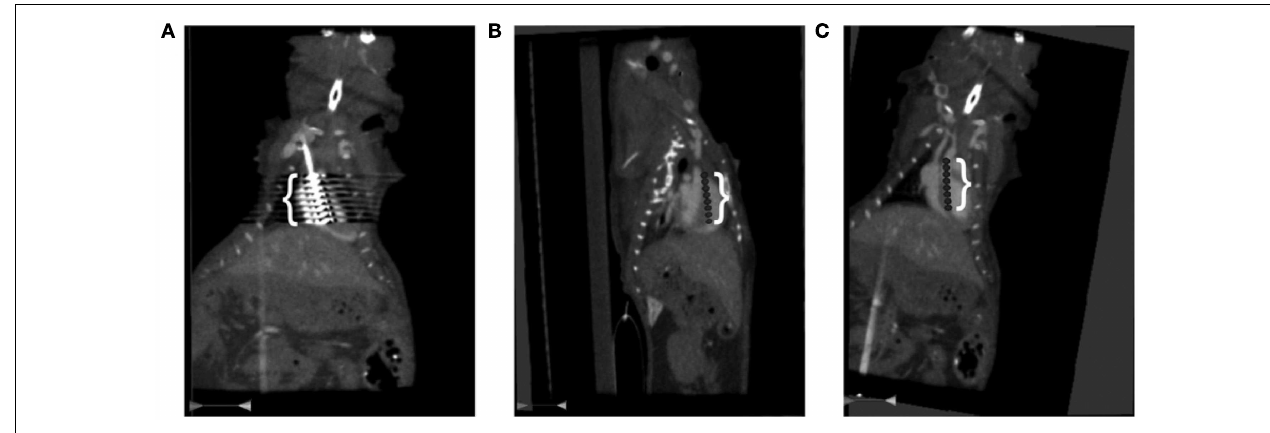
delineates the position of the catheter’s eight electrodes.The bright dots to the left of the torso are from the ribs and those on the left are from the spinal column. (C) A coronal view of catheter placement with electrodes three and four across the tricuspid valve.The white bracket delineates the catheter’s eight electrodes.The bright dots to the left and right of the torso are from the